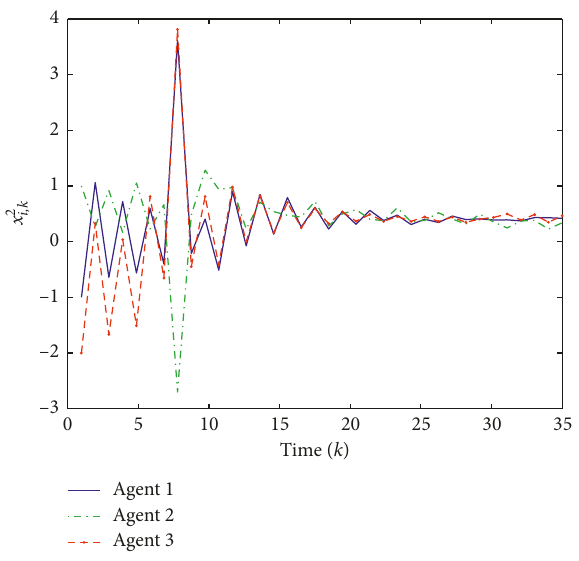
Figure 4: The state trajectories of x 2